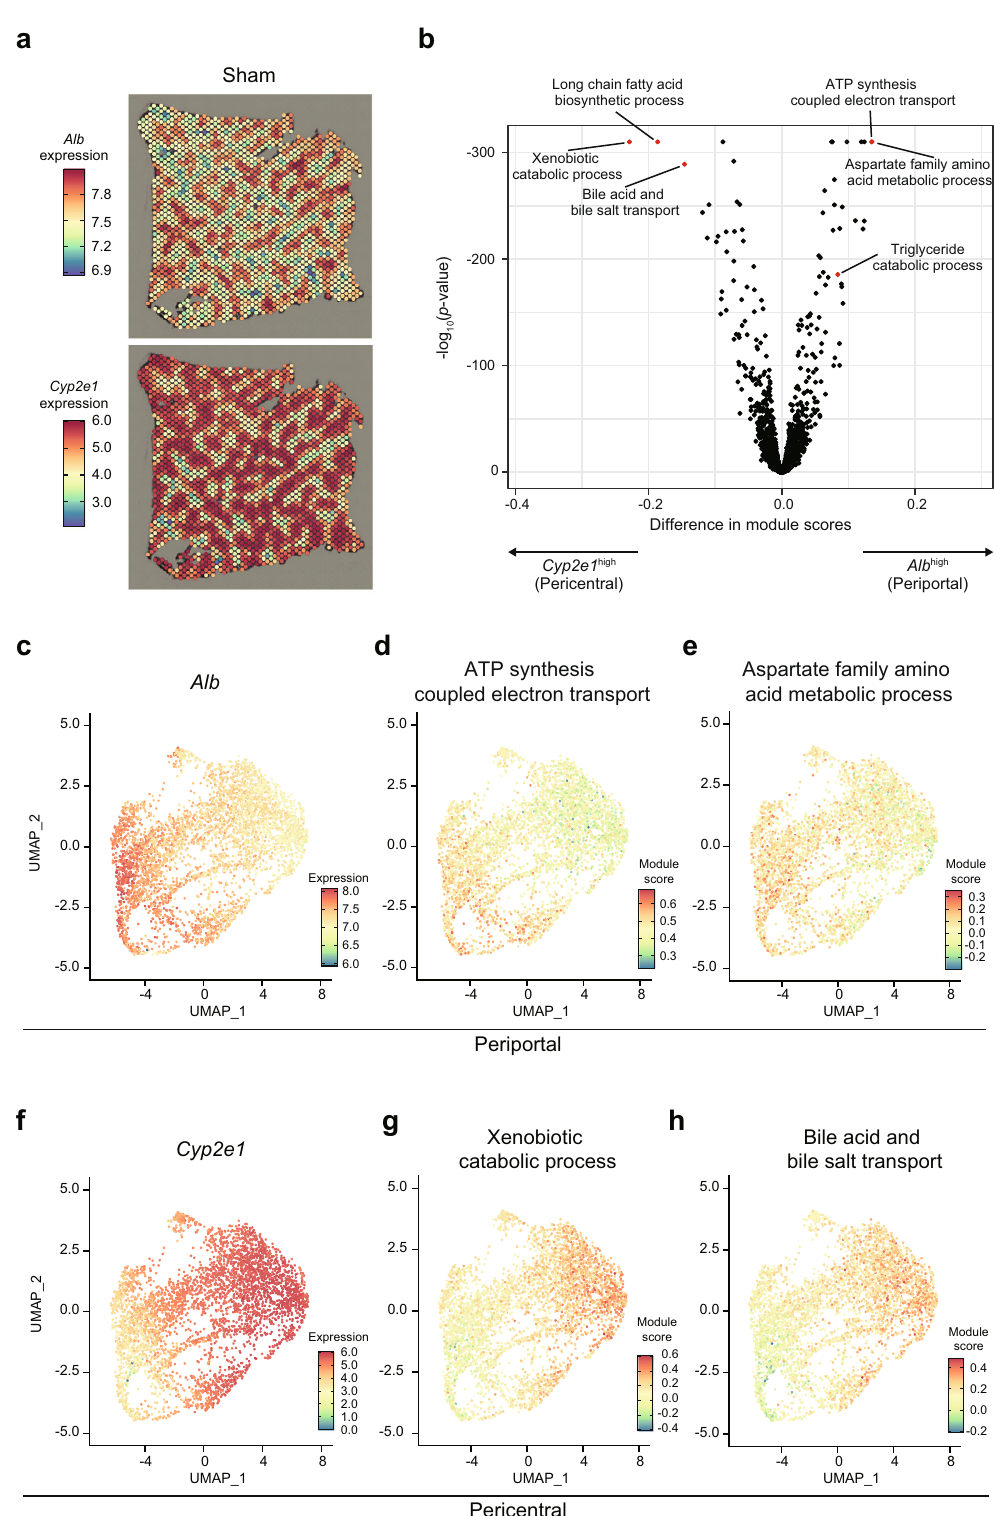
Fig. 1 Visualization of liver zonation using spatial transcriptomics. a Alb and Cyp2e1 expressions in one of the sham samples. A second sample is shown in Supplementary Fig. 1. b Volcano plot of the module scores of 2898 GO terms. The x -axis shows the difference in module scores between Alb high and Cyp2e1 high zones. The y -axis shows the p -values ( − log 10 ) of a Wilcoxon Rank Sum test. Supplementary Fig. 2 shows the same plot with more GO terms indicated. c – h UMAP plots of the Visium spots of the two sham samples. c UMAP_1 is anti-correlated with Alb expression. Spots on the left side represent the periportal zone with high Alb expression. Genes involved in the ATP synthesis coupled electron transport ( d ) and the aspartate family amino acid metabolism ( e ) have high activity in the periportal zone. f UMAP_1 is correlated with Cyp2e1 expression. Spots on the right side represent the pericentral zone with high Cyp2e1 expression. Genes involved in the xenobiotic catabolic process ( g ) and the bile acid and bile salt transport ( h ) have high activity in the pericentral